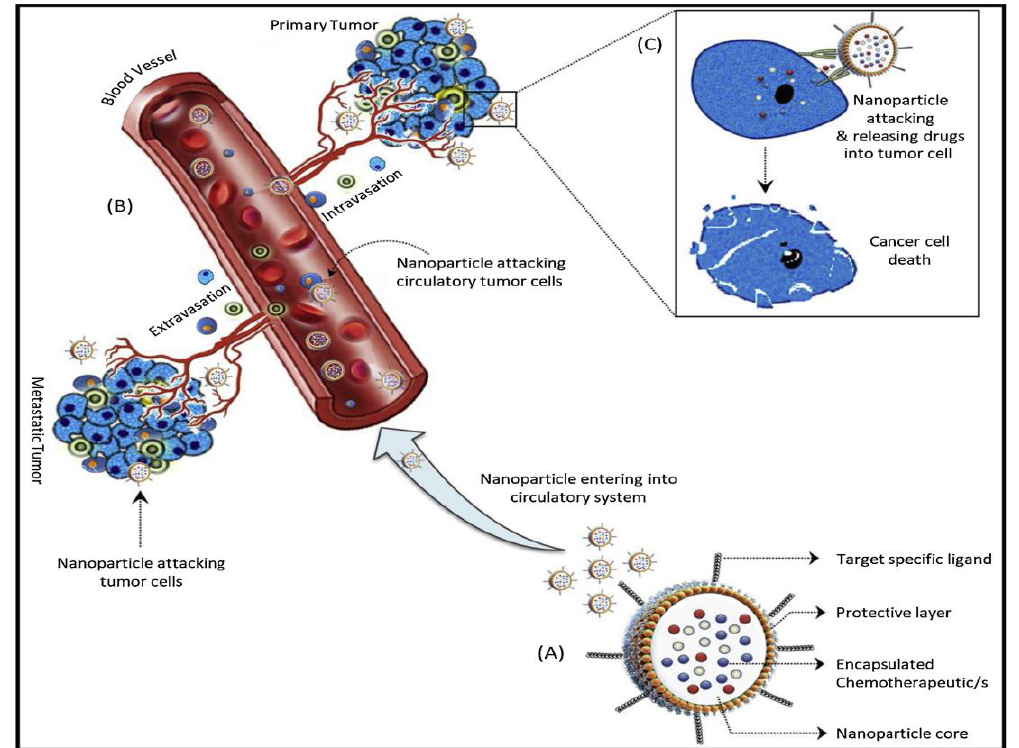
Figure 4. Cancer nanotherapeutics steps: ( A ) Nanoparticles with a protective layer loaded with chemotherapeutics of interest and decorated with target specific ligand. The drug loaded in the core of the nanoparticle can specifically recognize target cells using target-specific ligands. ( B ) Nanotherapeutics can reach primary and secondary tumors after entering the circulatory system and target specific tumor cells through the intravasation and extravasation processes. ( C ) Encapsulated chemotherapeutics are released after binding of tumor specific ligand and target cells surface receptors that causes cellular death. Reproduced from Ref. [34] , (2022), with permission from Elsevier.